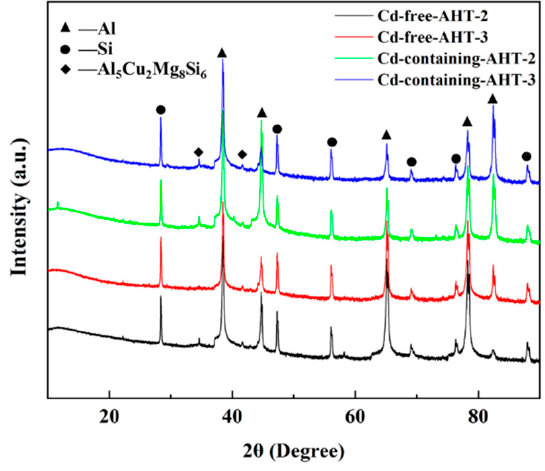
Figure 9. XRD patterns of Cd-free and Cd-containing after different heat treatment.